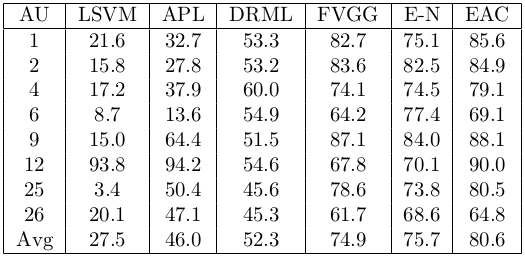
Table from the paper: EAC-Net: A Region-based Deep Enhancing and Cropping Approach for Facial Action Unit Detection
Table text:
AU
LSVM
APL
DRML
FVGG
E-N
EAC
1
21.6
32.7
53.3
82.7
75.1
85.6
2
15.8
27.8
53.2
83.6
82.5
84.9
4
17.2
37.9
60.0
74.1
74.5
79.1
6
8.7
13.6
54.9
64.2
77.4
69.1
9
15.0
64.4
51.5
87.1
84.0
88.1
12
93.8
94.2
54.6
67.8
70.1
90.0
25
3.4
50.4
45.6
78.6
73.8
80.5
26
20.1
47.1
45.3
61.7
68.6
64.8
Avg
27.5
46.0
52.3
74.9
75.7
80.6